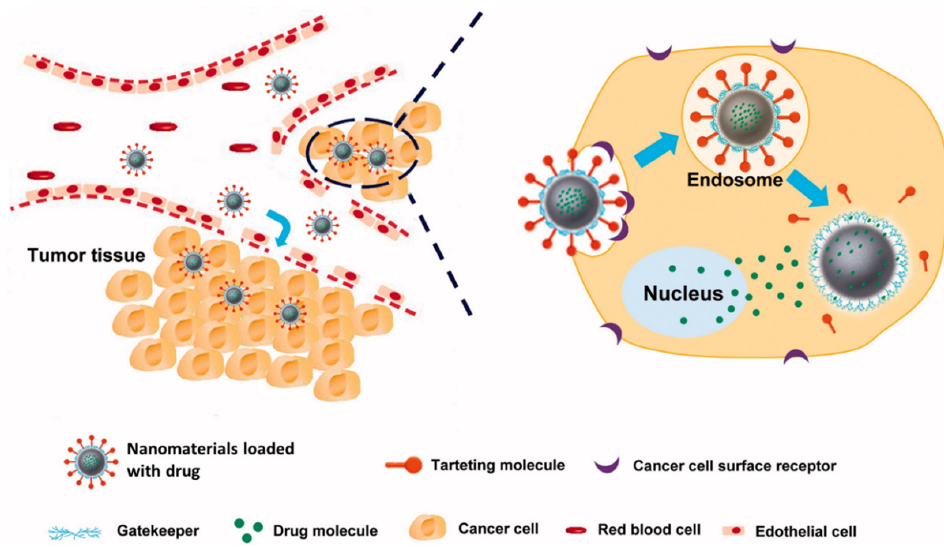
Figure 1. Schematic illustration of targeted drug delivery system. Reprinted with permission from Ref. [18]. Copyright 2017 Taylor &